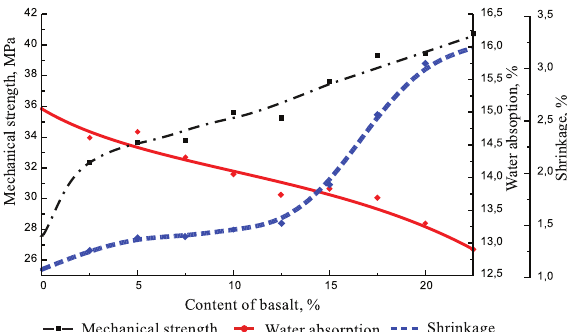
Fig. 6. Dependence of physico-chemical properties of fired samples of tiles on content of